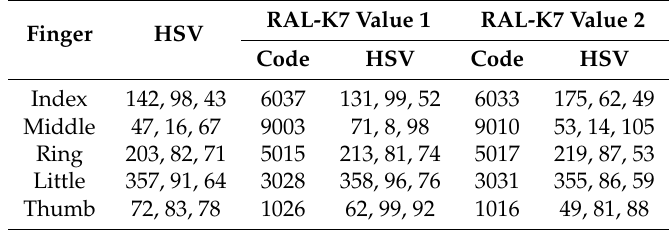
Table 2. HSV colors for diver gloves and RAL-K7 chart using camera setup from Section